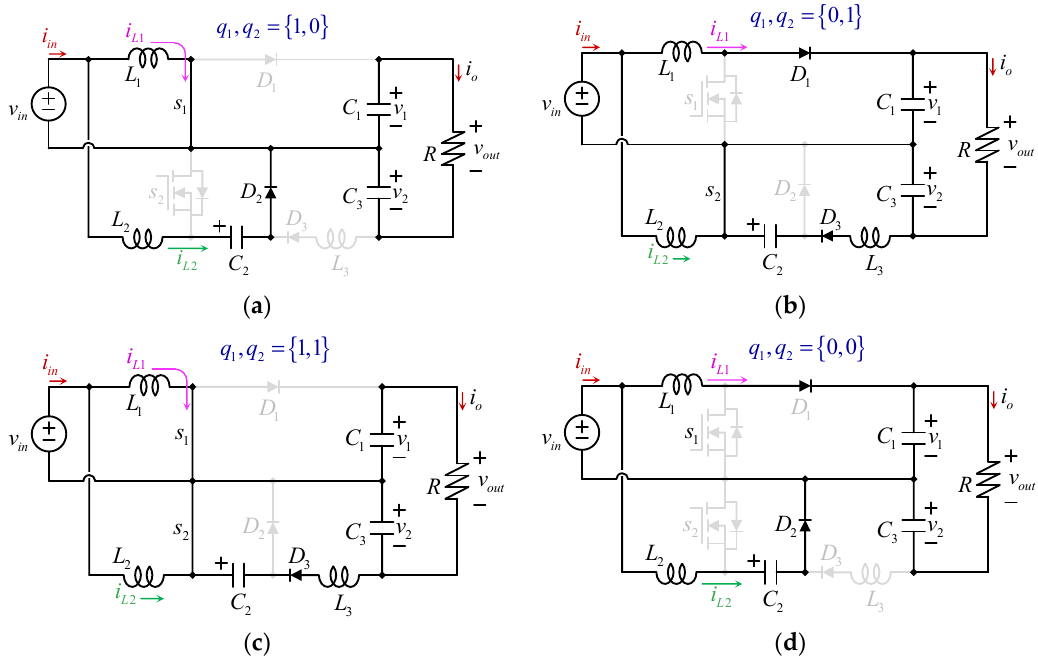
Figure 4. Equivalent circuits for the various commutation states: ( a ) state: q 1 , q 2 = {1,0}, current through L 1 increases whereas that which runs through L 2 decreases; ( b ) state: q 1 , q 2 = {0,1}, opposite to the state in ( a ); ( c ) state: q 1 , q 2 = {1,1}, both inductors’ currents increase; and ( d ) state: q 1 , q 2 = {0,0}, both inductors’ currents decrease.